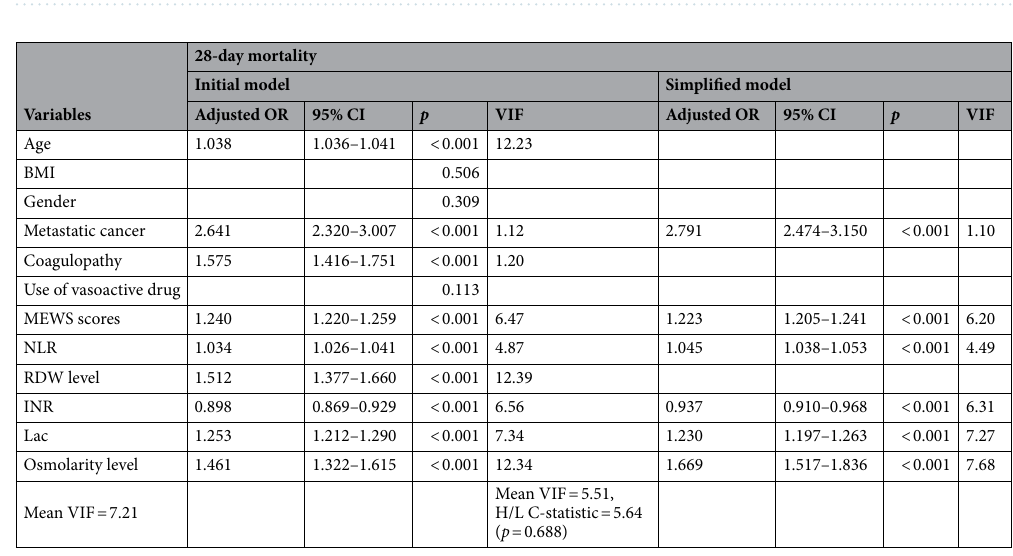
Table 7. Multivariate analyses and VIF assessment of factors associated with 28-day mortality rate in development cohort.